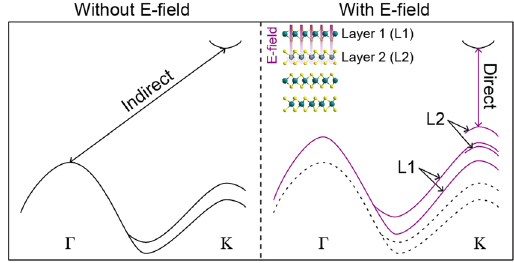
Figure 1. Schematic of electronic structure change in MoSe 2 upon application of an electric field. The band structure of MoSe 2 along the Γ -K direction without (left) and with (right) an external electric field applied perpendicular to the layers. The nature of the gap is also marked by the arrows. The inset illustrates the crystal structure and an applied electric field. L1 and L2 refer to the surface and sub-surface layers,